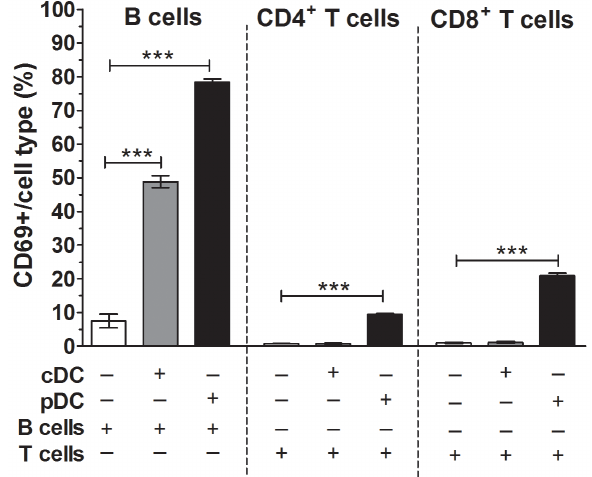
Figure 8. Plasmacytoid DC contributed to B cell and T cell activation by RRV. Sorted cDC (1 6 10 5 ) (grey bars) or pDC (1 6 10 5 ) (black bars) were cultured with sorted B or T cells (4 6 10 5 ) in the presence of RRV for 24 h. As controls, sorted B and T cells alone were stimulated with RRV as above (white bars). The proportion of CD69- expressing B cells, CD4 + T cells and CD8 + T cells following stimulation is shown, corrected for the proportion of background CD69 expression on unstimulated cells shown in Figure S7B. Data are derived from one experiment and are representative of two independent experiments. Error bars indicate the mean 6 SEM of 3 replicates. * p , 0.05, ** p , 0.01 and *** p , 0.001.